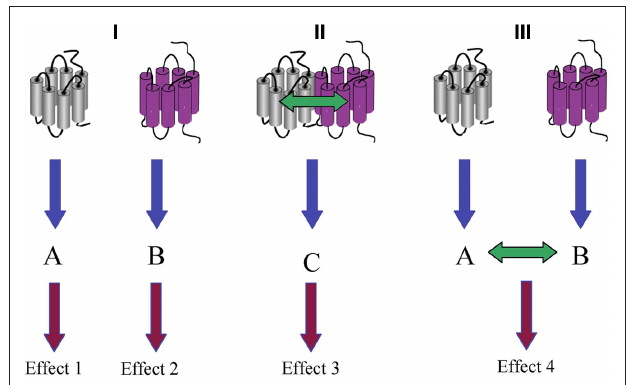
FiGuRE 1 | Functional versus physical interaction of GPCRs. (i) In the absence of any physical or functional interaction, the activation of two different GPCRs induces two independent signaling pathways A and B, which consequently result in two independent effects 1 and 2. (ii) Physical interaction of two different GPCRs results in the activation of the heteromer- specific signaling pathway C that will be responsible of a downstream effect 3. (iii) In the absence of physical interaction, a functional interaction can be observed when signaling pathways A and B crosstalk to produce effect